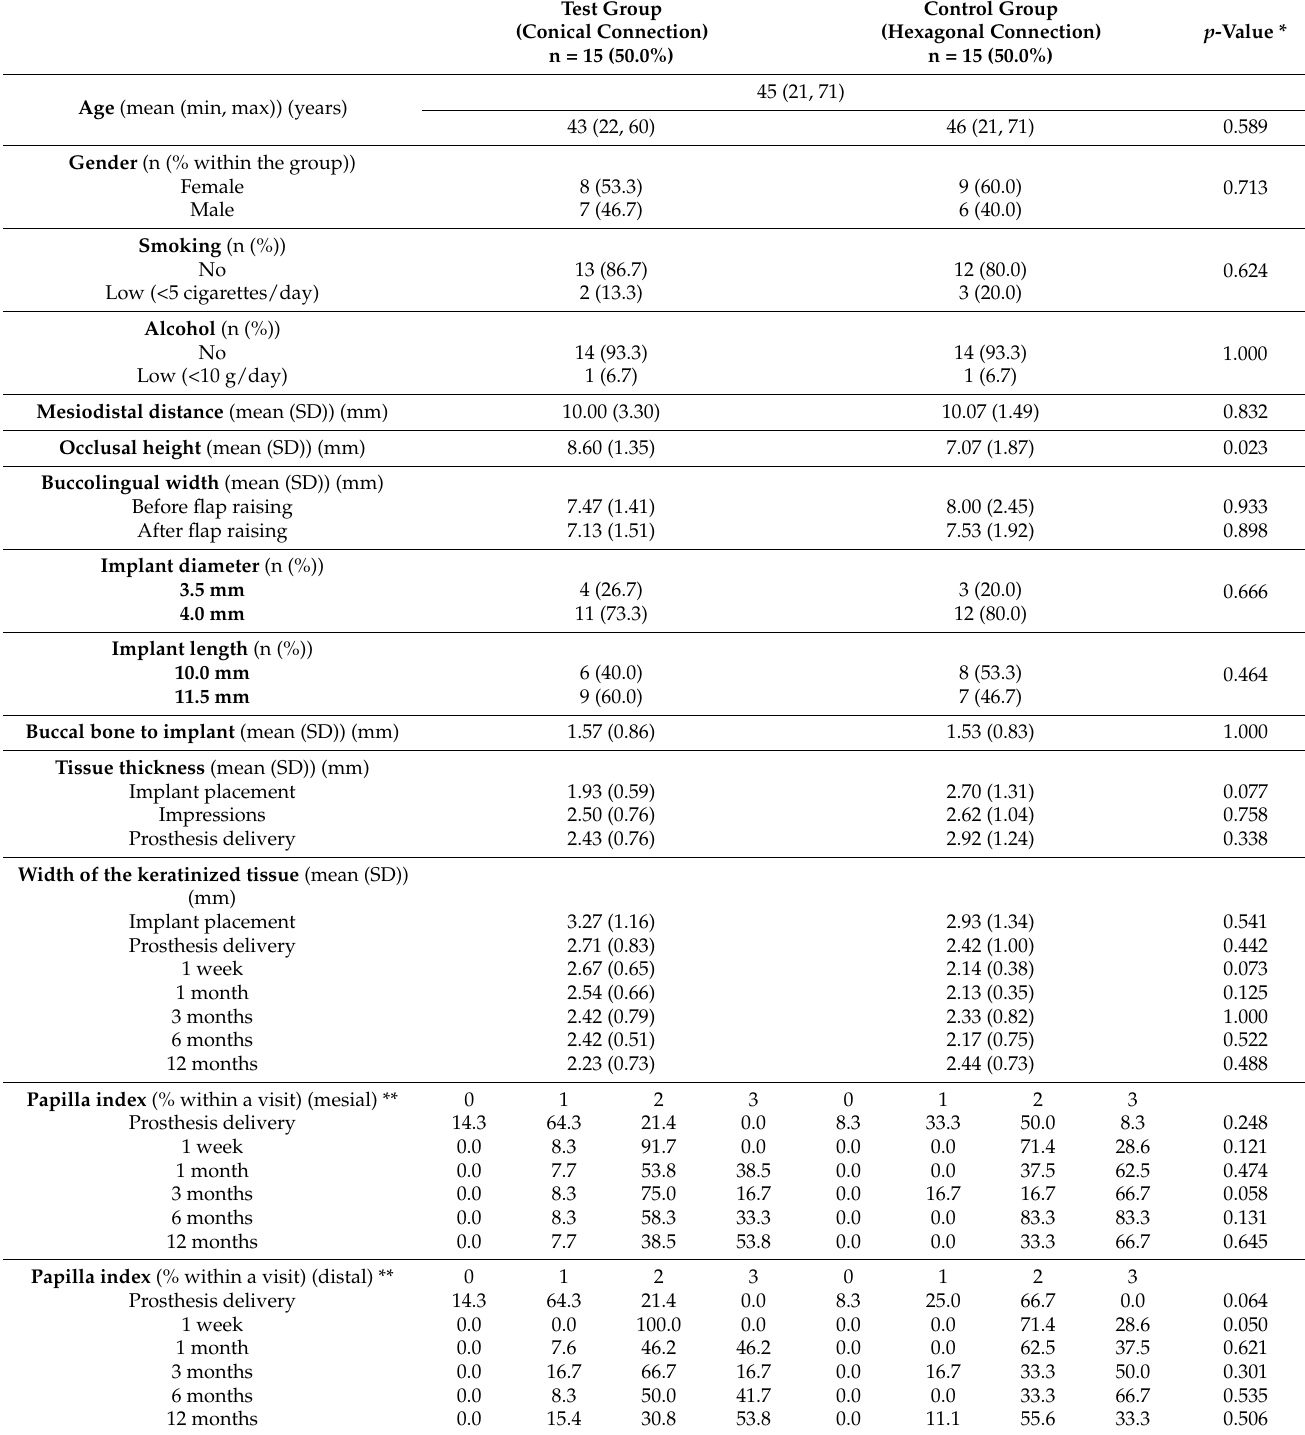
Table 1. Description and comparison of demographic and clinical